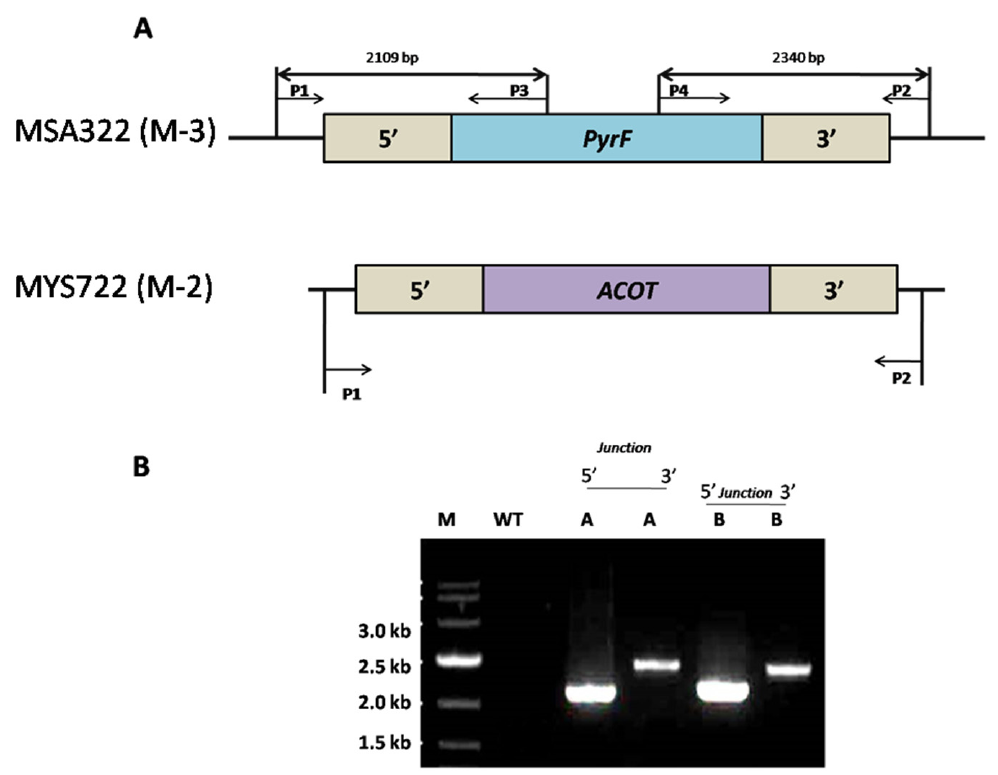
Figure 5. Confirmation of ACOT gene knockout in the mutant strains (i.e., M-3); MSA322 ( A ) The acot Δ :: pyrF allele was verified by junction PCR. P1 and P2 primers recognize the sequences outside of the disruption construct. P3 and P4 primers only recognize the pyrF gene marker. P1: YS-381; P2,